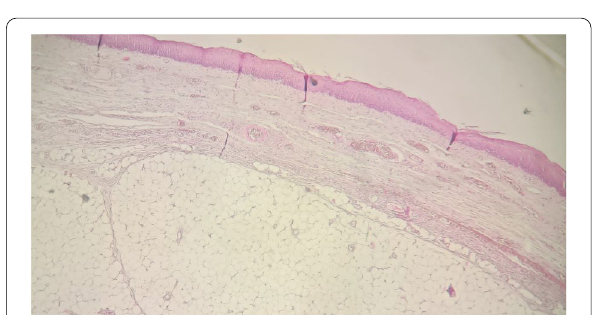
Fig. 4 Benign submucosal adipocyte proliferation